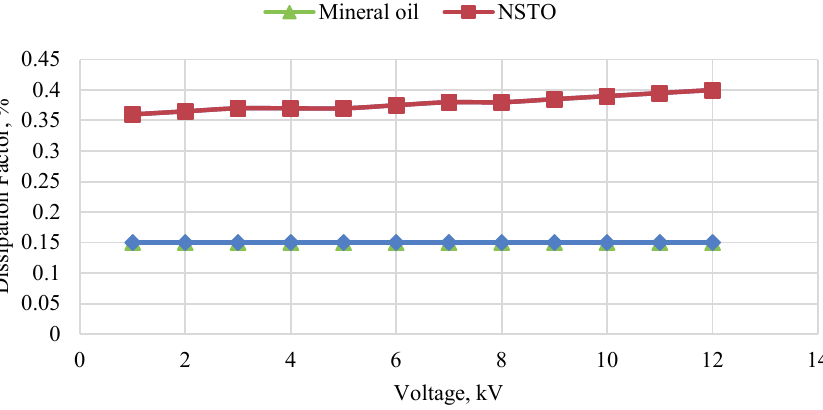
Fig. 1. Tan delta changes in relation to